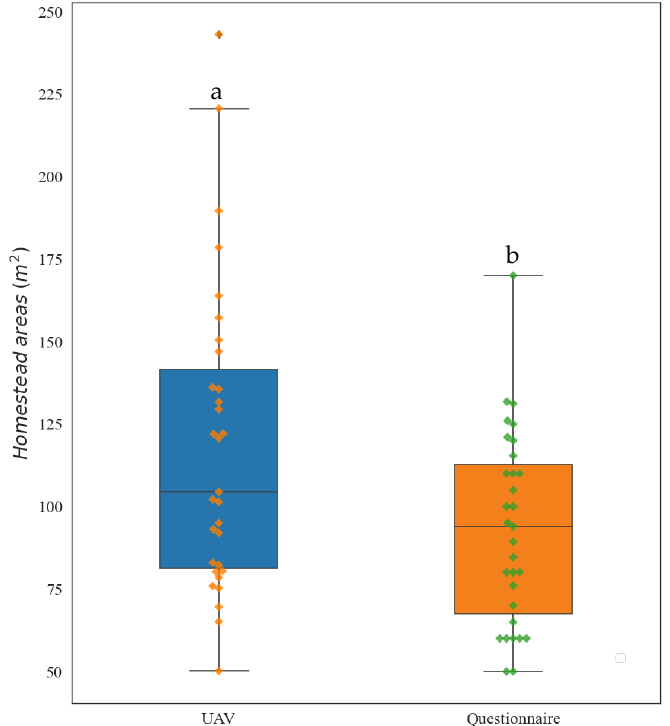
Figure 4. Difference in rural homestead areas obtained using a questionnaire and a UAV. Different letters represent a significant difference between the control and the treatment groups (N = 31, p < 0.01).